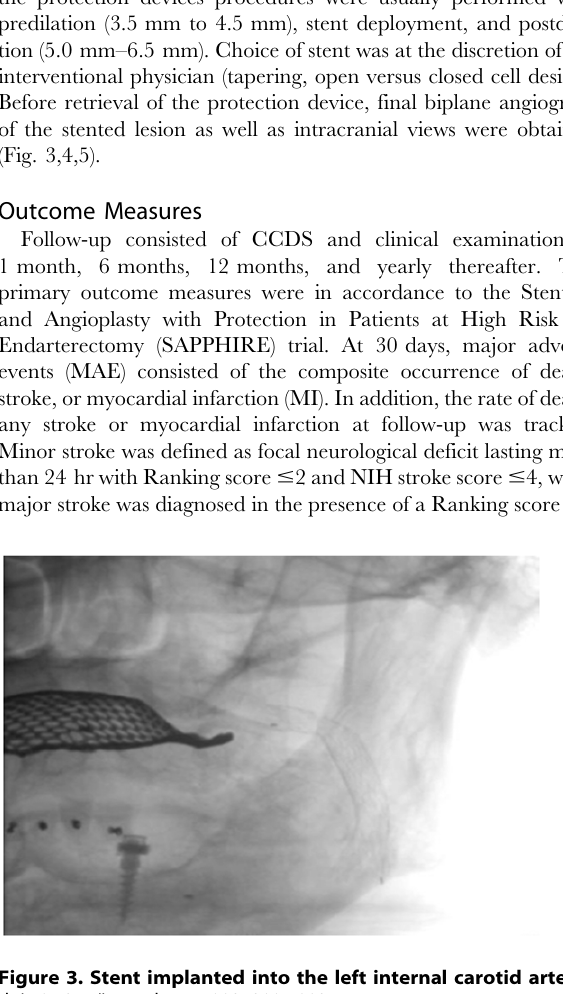
Figure 3. Stent implanted into the left internal carotid artery.